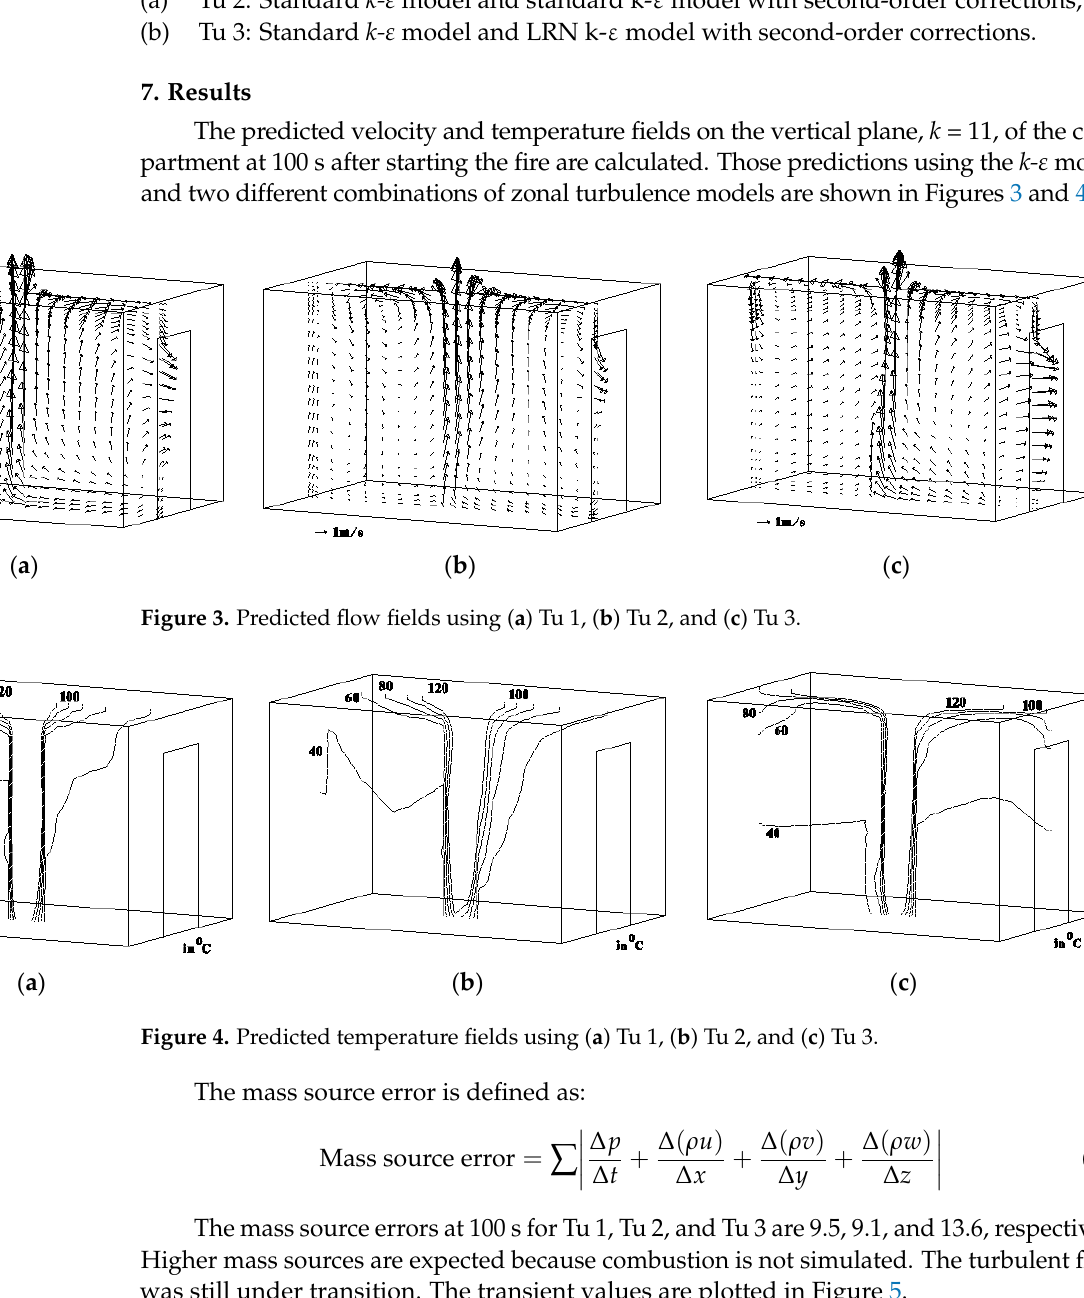
Figure 5. Comparison of the time dependence of mass source errors. The percent deviation PD is given by: